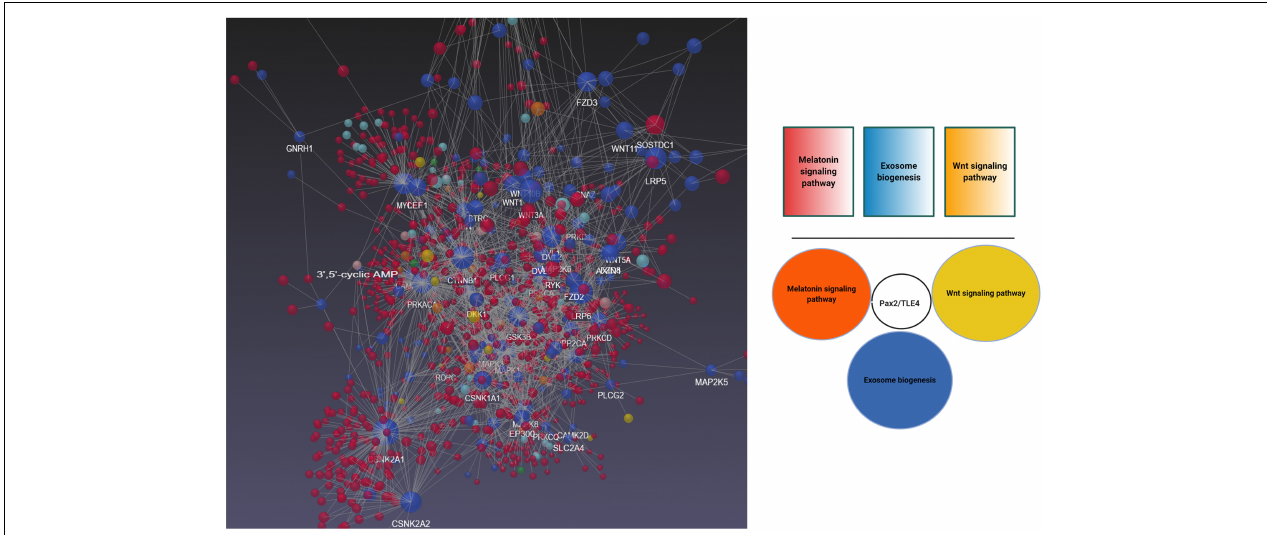
FIGURE 6 | Bioinformatics Analysis of Gene Expression Profiles of Wnt and melatonin signaling pathways with exosome biogenesis using NetworkAnalyst version 3. Data revealed shared Pax2/TLE4 interaction between Wnt, melatonin signaling pathway with exosome biogenesis.